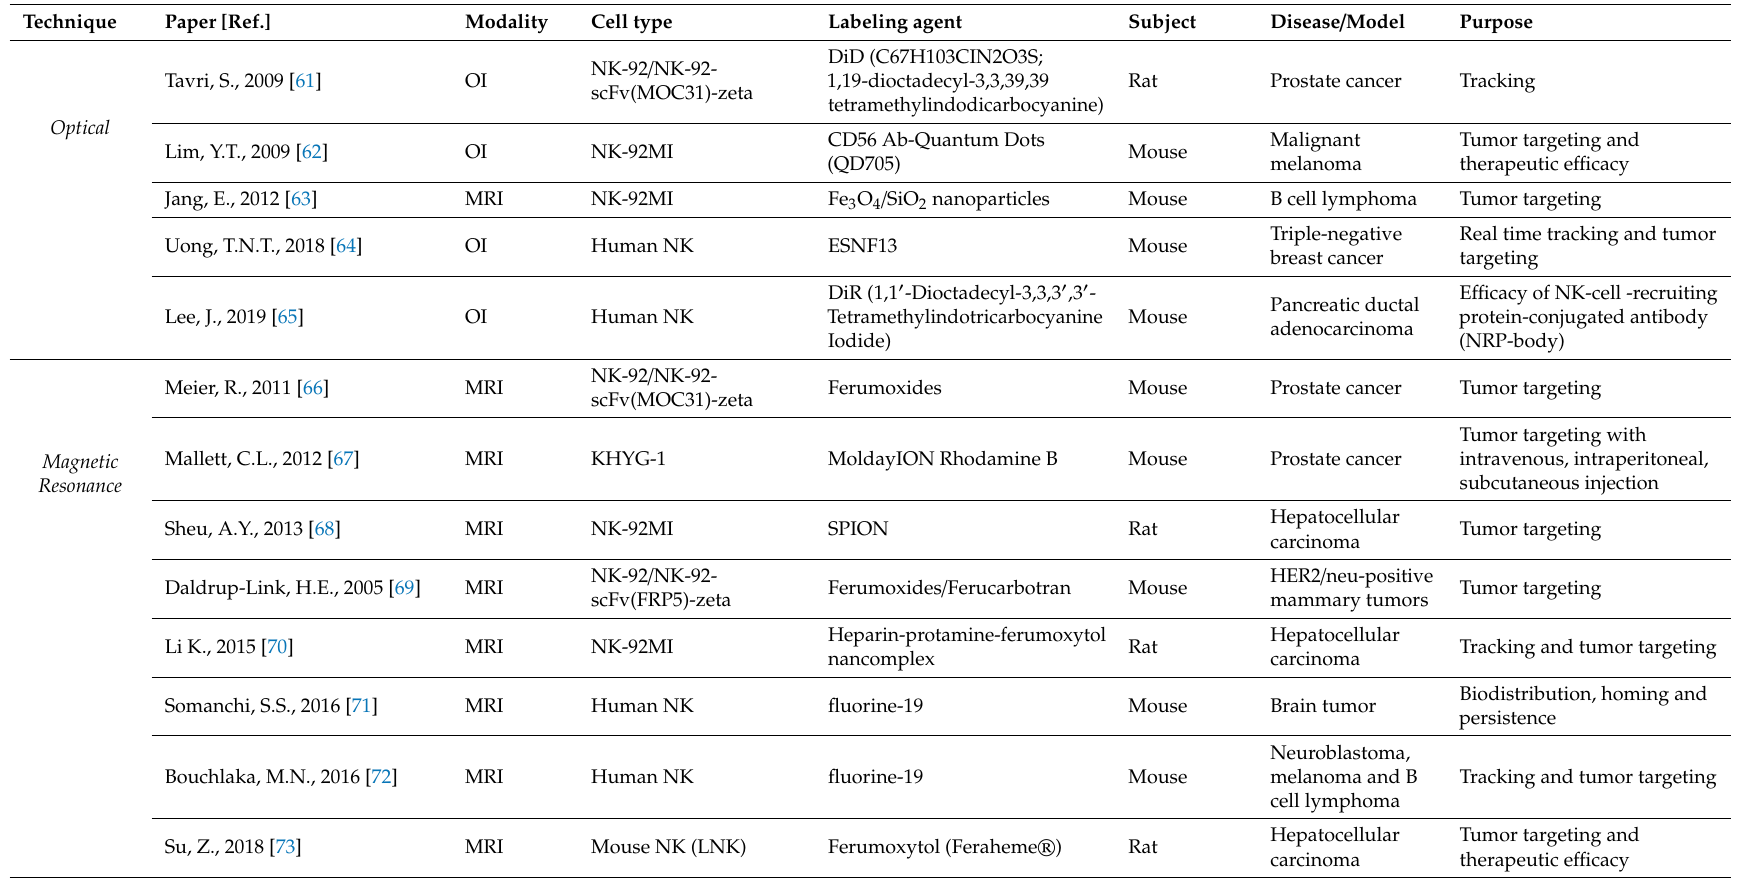
Table 2. Summary of papers included in the